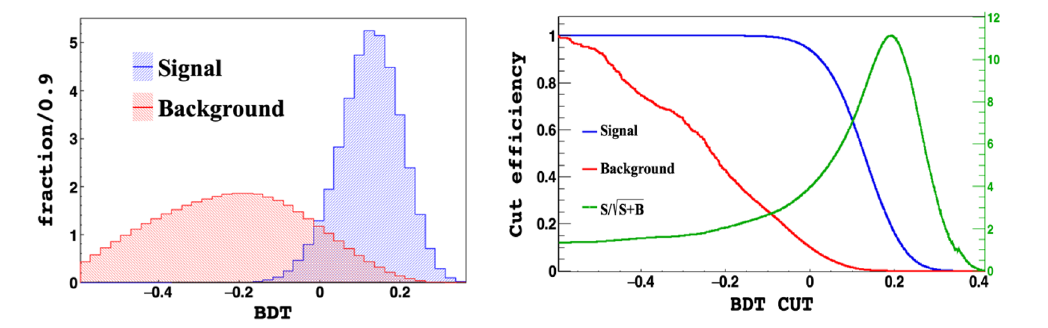
Figure 10 . Left: the distribution of the Boosted Decision Tree response to the signal (blue) and to the background (red), superimposed. Right: Cut efficiency as a function of the BDT cut. For a √ cut value greater than 0 . 193 one can get S/ S + B = 11 σ with number of signal events = 939 and background events = 6185 . The cut efficiency for the signal is 0 . 187 and for the background 0 . 0004 .